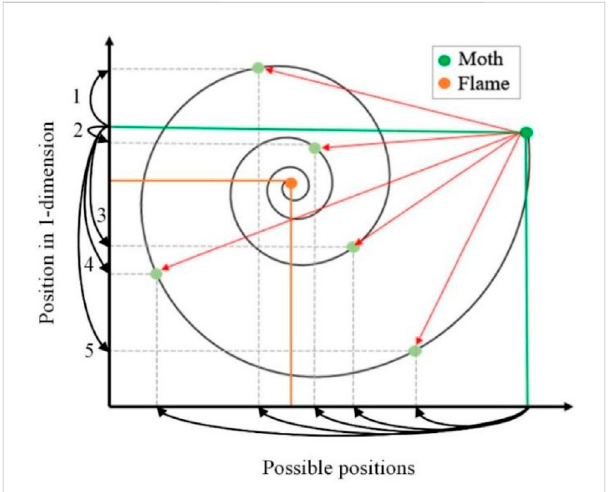
FIGURE 1 Conceptual model for moth – fl ame algorithm to update moth ’ s location according to a fl